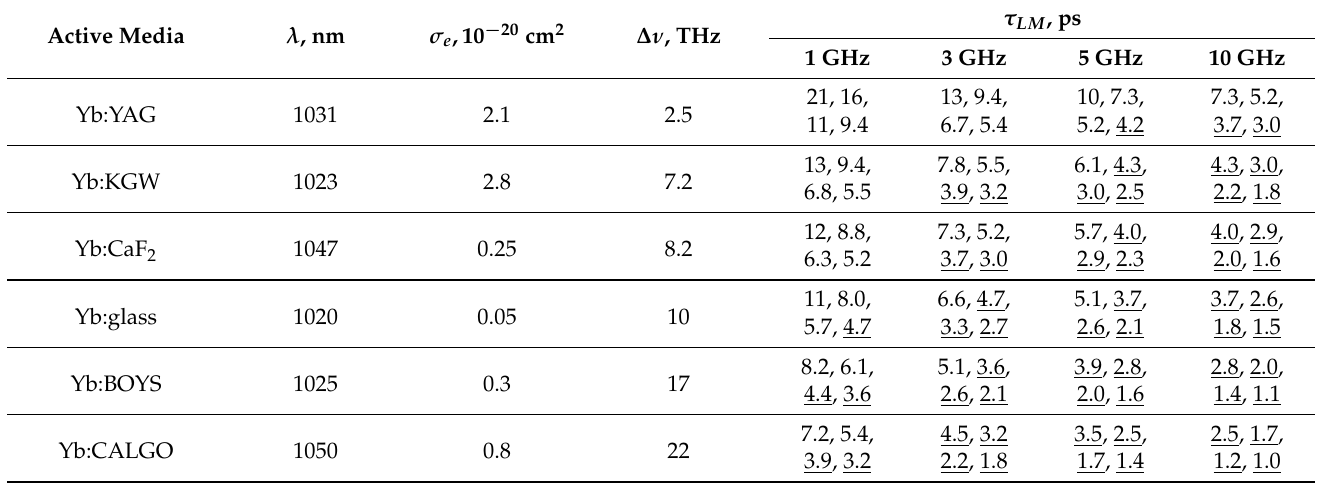
Table 2. Pulse duration τ LM estimated for typical Yb-based active media [33] with modulation depth a = 25%, 50%, 100%, 150%. λ is wavelength and ∆ ν is emission bandwidth. G = 1.3, S =